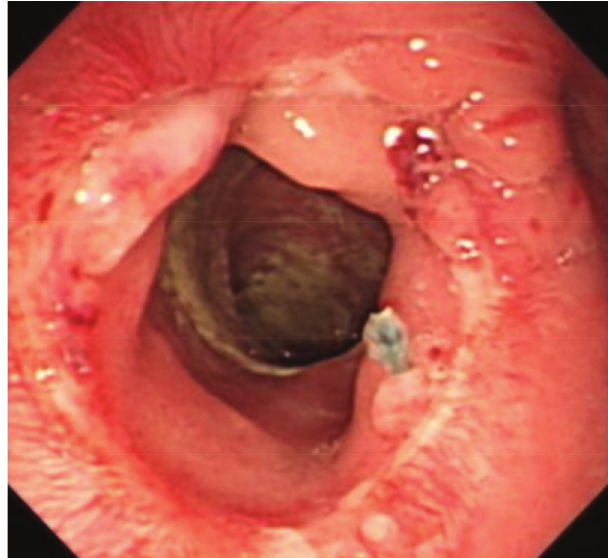
Figure 3 - One patient experienced anastomosis stricture after 3 months post-operation as determined by an electronic colonoscopy.